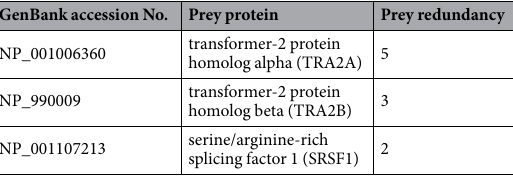
Table 1. Potential ILDR1-binding partners identified from yeast two-hybrid